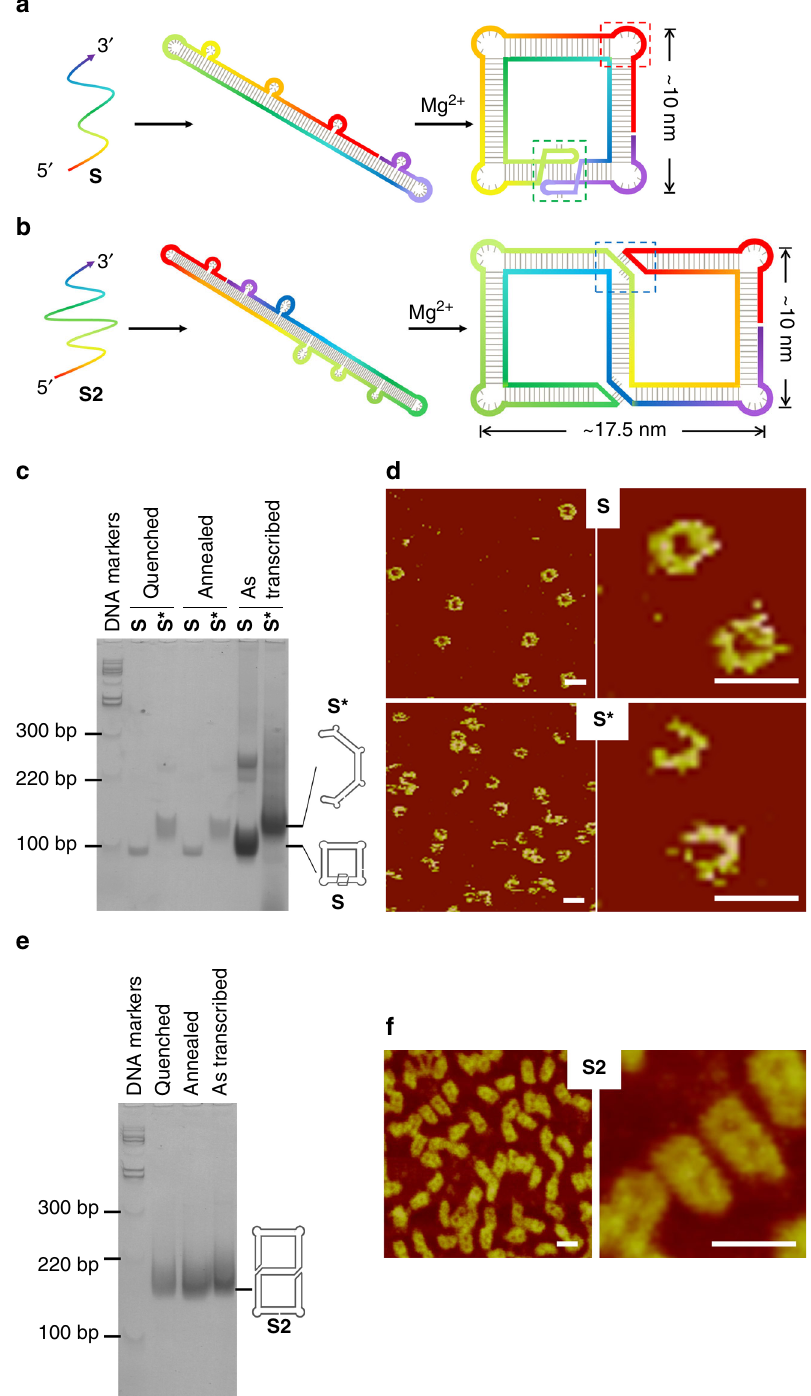
Fig. 2 Designs, folding, and characterization of an RNA square ( S ) and an RNA double square ( S2 ). a , b The molecular design and single-stranded folding pathways for S and S2 , respectively. The RNA single strands are colored in a rainbow gradient from 5 ′ (red) to 3 ′ end (purple). Red, green, and blue boxes with dashed lines highlight a 90° - kink, a KL interaction, and a 3WL interaction, respectively. Each edge is composed of a two-turn RNA duplex. Characterization of c , d RNA square and e , f RNA double square. c , e electrophoretic analysis; d , f Atomic force microscopy (AFM) imaging. Note that S* has the same sequence as S except that one loop sequence is altered so that no KL interaction can form. (Scale bar: 20